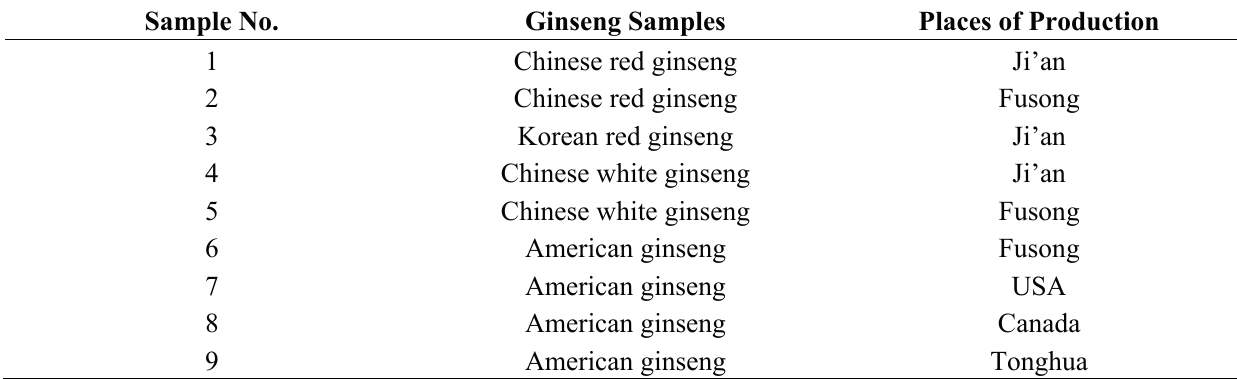
Table 1. Details of the